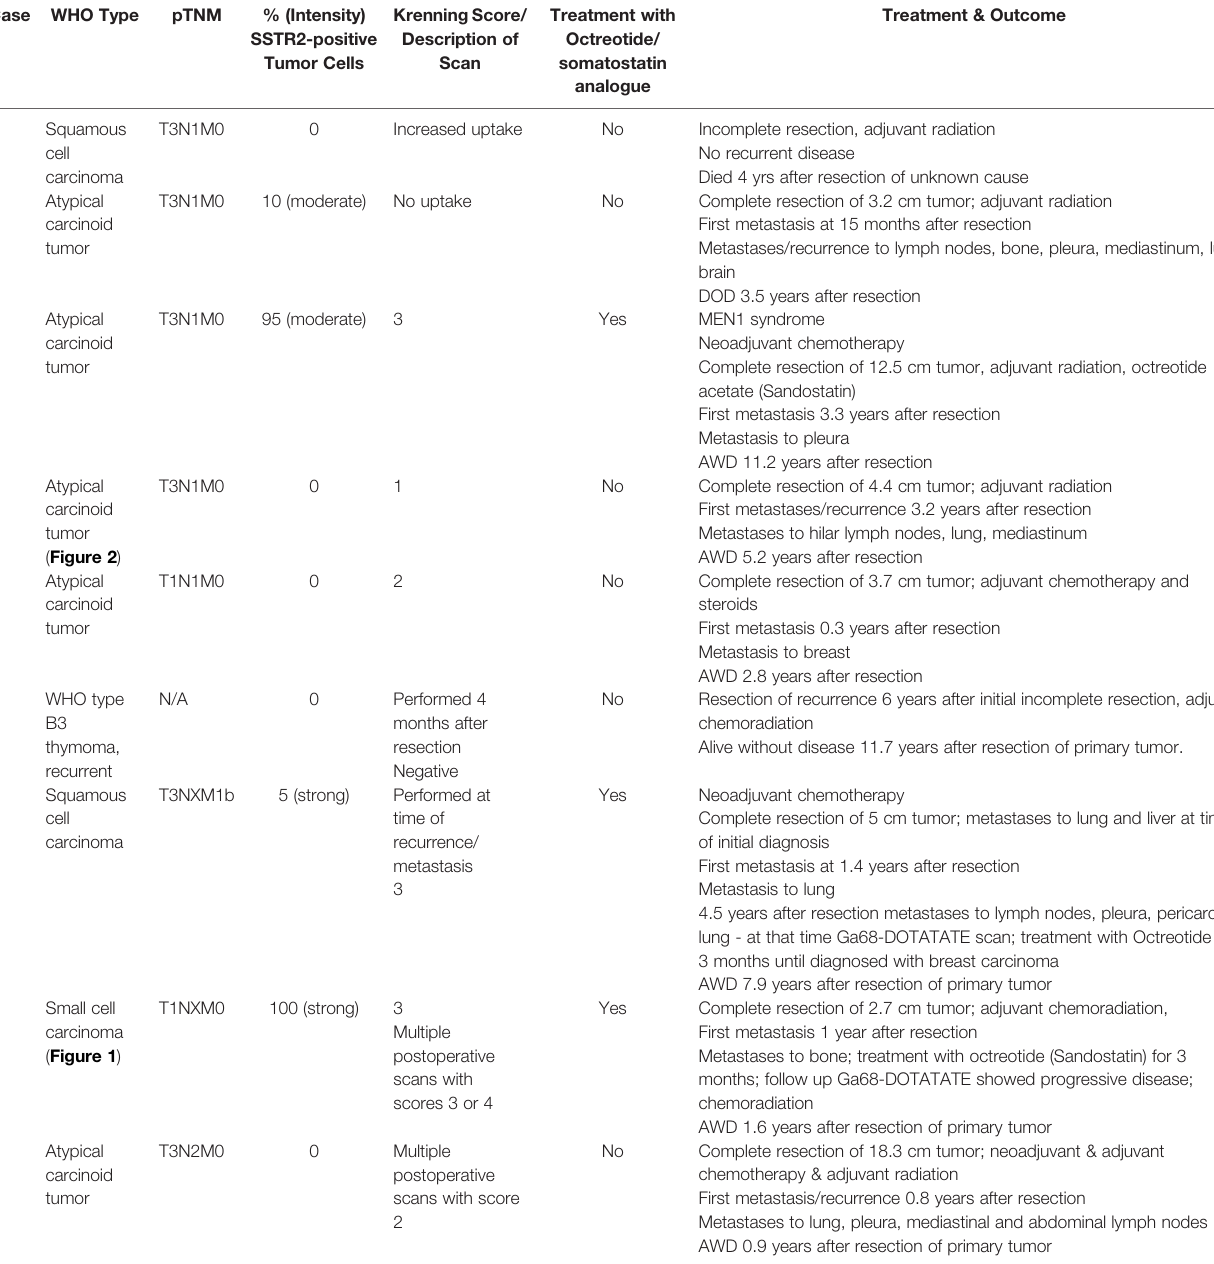
TABLE 4 | Summary of patients with available DOTATATE